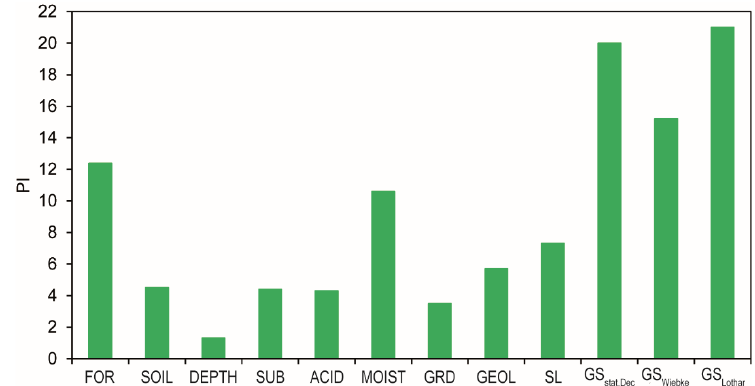
Figure 7. Predictor Importance ( PI ) of random forests model output for modeled proportions of storm-damaged timber in the period 1979–2008 with Wiebke and Lothar gust speed fields being included in model building.